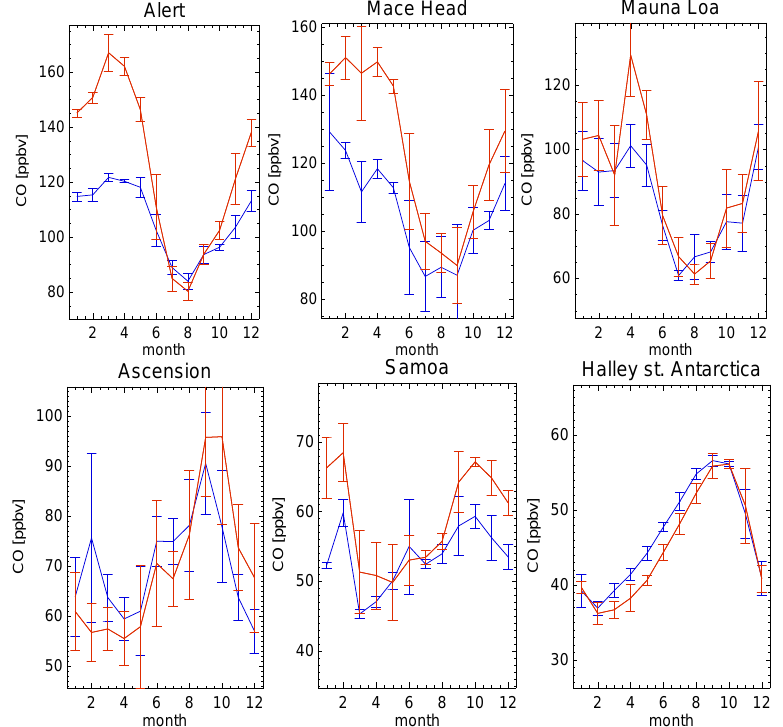
Fig. 3. Monthly mean comparison of TM5 surface CO (blue) against GMD surface observations (red) using co-located model output for 2006, sampled at the measurement times. The error bars indicate the standard deviation in the monthly means.